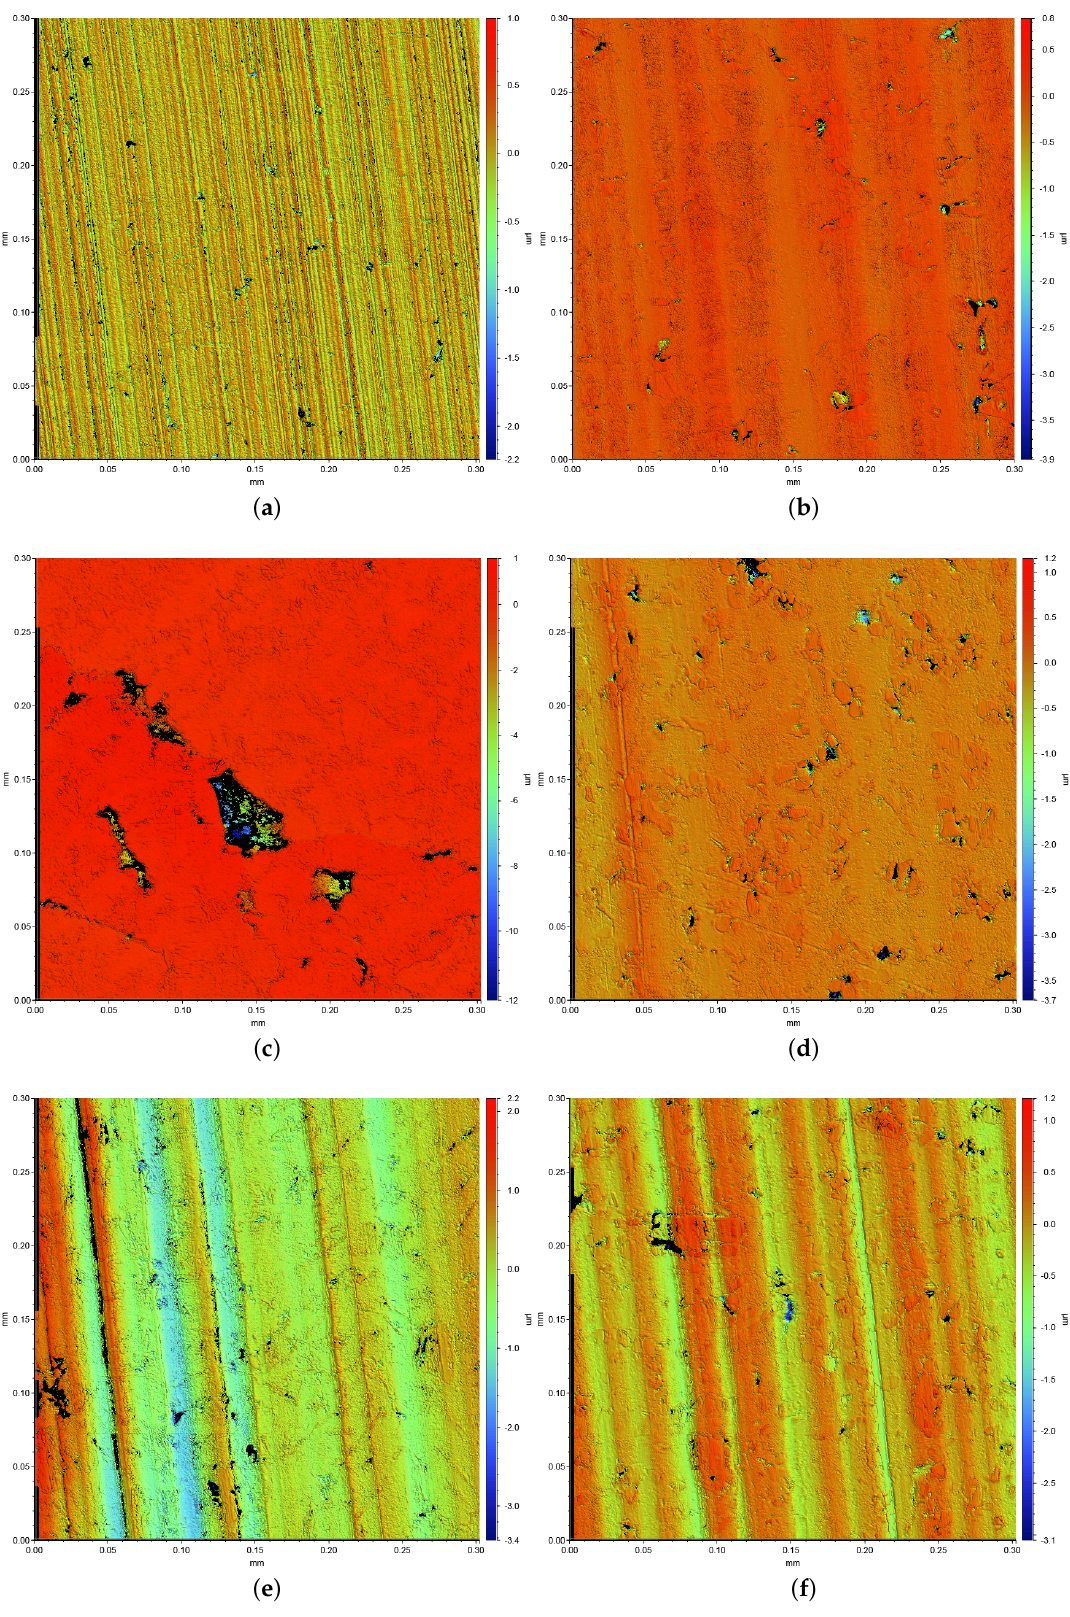
Figure 8. WLI images of the pin surfaces following the wear tests at 15.9MPa MPa contact pressure. Note the differences in scaling of the height values. ( a ) 6.6% Si as-cast, ( b ) 6.6% Si FS, ( c ) 10.4% Si as-cast, ( d ) 10.4% Si FS, ( e ) 14.6% Si as-cast, and ( f ) 14.6% Si